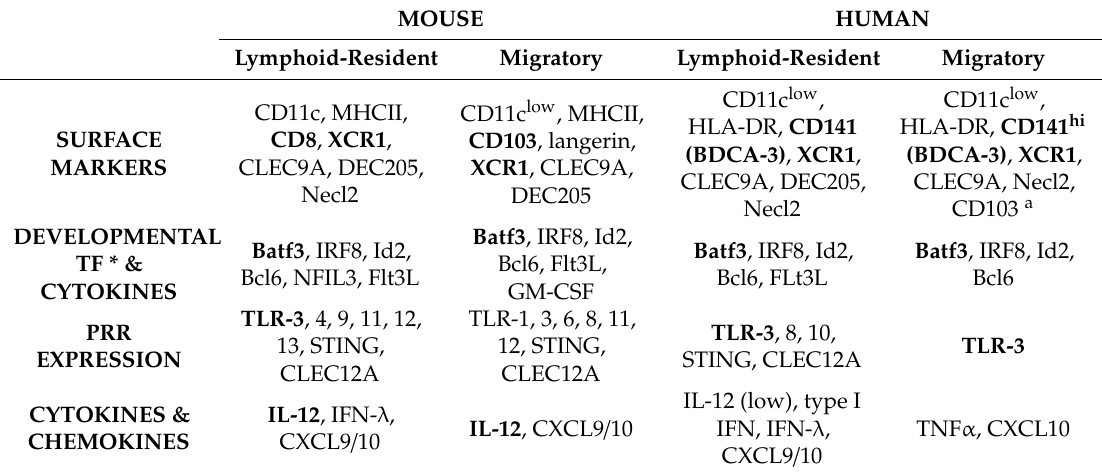
Table 1. Phenotype of lymphoid-resident and migratory cross-presenting dendritic cells (DCs) in mice and humans. MOUSE HUMAN Lymphoid-Resident Migratory Lymphoid-Resident Migratory